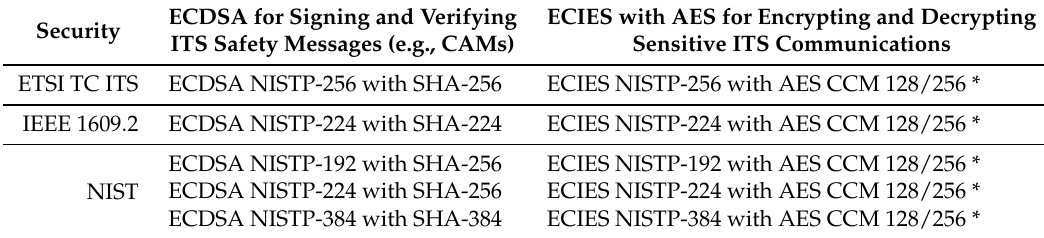
Table 2. Benchmarked security